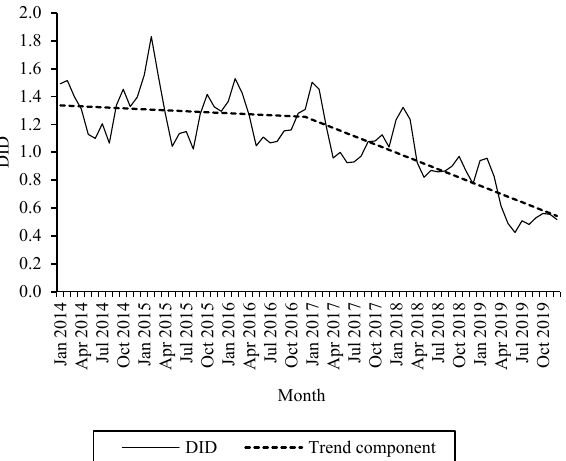
Figure 3. Monthly fluoroquinolone DID during 2014–2019 in Germany and calculated trend. Table 4. Trends for fluoroquinolone DID during 2014–2019. Abbreviations: DID 2014 , Average DID in 2014; DID 2019 , Average DID in 2019; Δ, percentage difference between 2019 and 2014 values; Avg, average monthly change in DID. In order to account for the different alpha levels for the individual federal states due to the Bonferroni-Holm method, Avg that are significantly different from zero are marked with *; R 2 , coefficient of determination for the applied model.